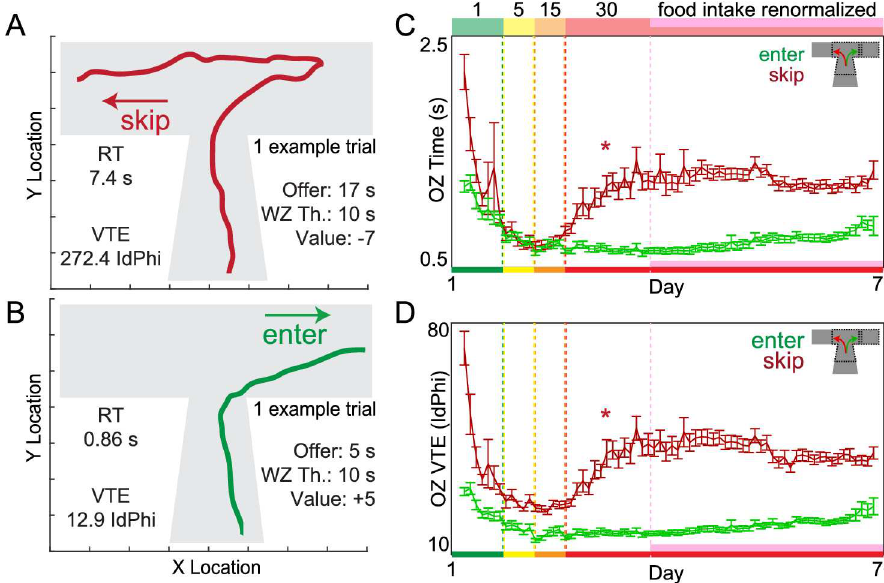
Fig 5. Development of deliberative behaviors during principal OZ valuations. (A-B) Example x and y locations of a mouse’s path trajectory in the OZ (wait zone not depicted) over time during a single trial (from day 70). (A) Skip decision for a high-delay offer. The mouse initially oriented toward entering (right) but then ultimately reoriented to skip (left). WZ Th. minus offer captures the relative subjective “value” of the offer. Negative value denotes an economically unfavorable offer. (B) Enter decision for positively valued offer; rapid without reorientations. This OZ trajectory pattern is indistinguishable from enter-then-quit decisions for negatively valued offers. (C) Average OZ RT split by enter versus skip decisions across days of training. (D) Average OZ VTE behavior split by enter versus skip decisions across days of training. Data are presented as the cohort’s ( N = 31) daily means ( ± 1 SE) across the entire experiment. Color code on the x-axis in (C-D) reflects the stages of training (offer cost ranges denoted from 1 to the number on the top of panel C). Vertical dashed lines (except pink) represent block transitions. (cid:3) indicates gradual significant changes within the 1–30 s block during the early 2 wk adaptation period. Data available as a supplemental file. OZ, offer zone; RT, reaction time; VTE, vicarious trial and error; WZ Th., wait zone